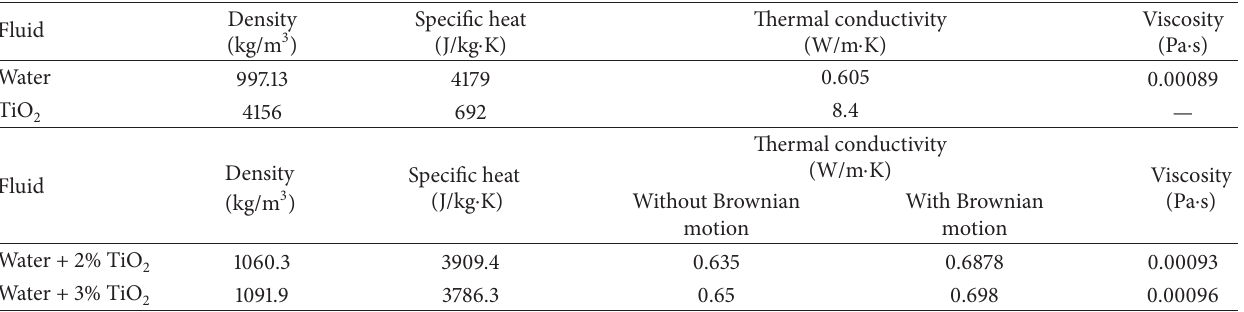
nanofluids of different concentrations. 2